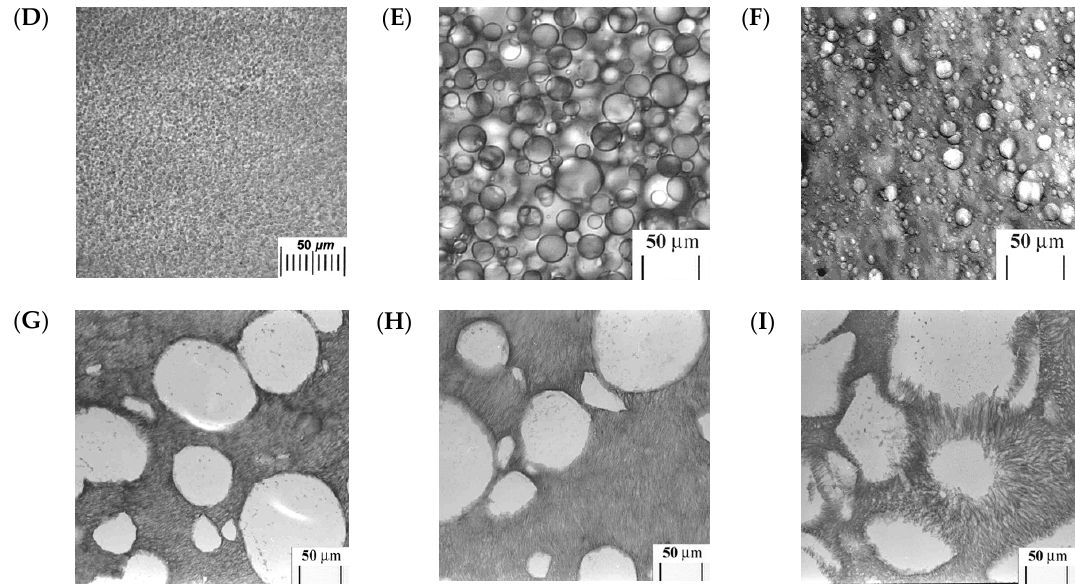
Figure 3. Micrographs demonstrating the influence of different dispersed fillers on the macroporous. morphology of various composite PVA cryogels (all the images were taken using transmission optical microscope for the 10- μ m-thick thin sections stained with Congo red): ( A ) PVA-based composite cryogel ( 45b , Table 1) formed in a frozen ( − 20 °C/24 h) aqueous system containing suspended Silasorb − 300 silica particles of 5 μ m in size. ( B ) PVA-based composite cryogel ( 45b , Table 1) formed in a frozen ( − 20 °C/24 h) aqueous system containing suspended Silasorb-C18 hydophobized silica particles of 7.5 μ m in size. ( C ) PVA-based composite cryogel ( 50 , Table 1) formed in a frozen ( − 20 °C/12 h) aqueous system containing added tetramethoxysilane, hydrolytic polycondensation of which gave rise to the formation of silica filler particles. ( D ) PVA-based composite cryogel ( 69b , Table 1) formed in a frozen ( − 20 °C/12 h) aqueous system containing PVA and chitosan hydrochloride followed by the in situ transformation of the soluble chitosan salt to the particulate water-insoluble chitosan-base. ( E ) Microdroplets of the Vaseline oil mechanically dispersed in the aqueous PVA solution. ( F ) Composite PVA cryogel ( 56a , Table 1) formed on the basis of above ( E ) emulsion by its cryogenic processing ( − 20 °C/12 h). ( G – I ) Foamed PVA cryogels ( 49 , Table 1) prepared by cryogenic processing ( − 30 °C/1 h and further − 20 °C/23 h) of the following fluid foams: air-whipped aqueous PVA solution ( G ); foam stabilized with the additives of Brij − 56 non-ionic surfactant; and ( H ) foam stabilized with the additives of CTAB cationic surfactant ( I ) . Note that all these micrographs are from the private archive of the author of the present review and were taken by him personally. CTAB, cetyltrimethylammonium bromide; Brij − 56, decaoxyethylene cetyl ether.